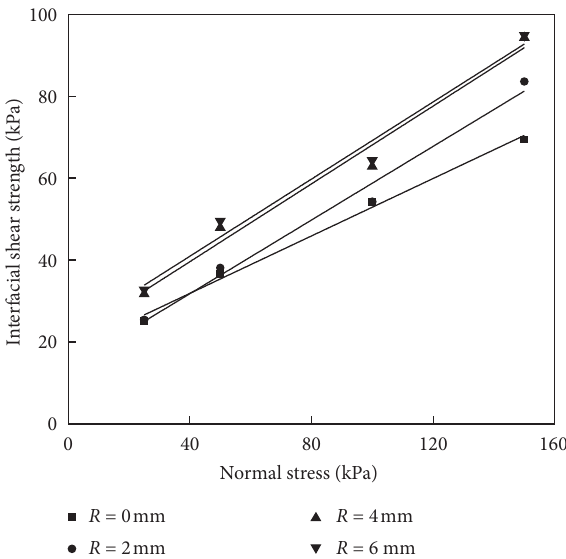
Figure 10: Relationship between shear strength of interface and normal stress.